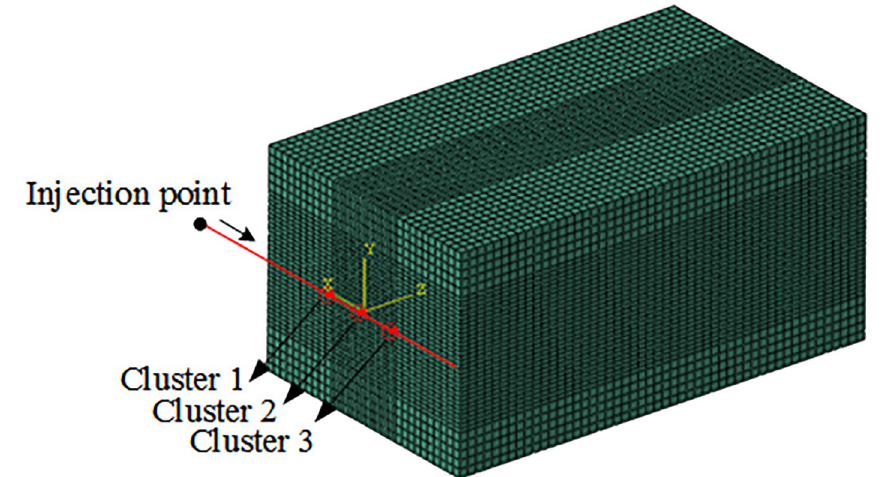
Fig 4. Mesh of three-dimensional fracture structure model.